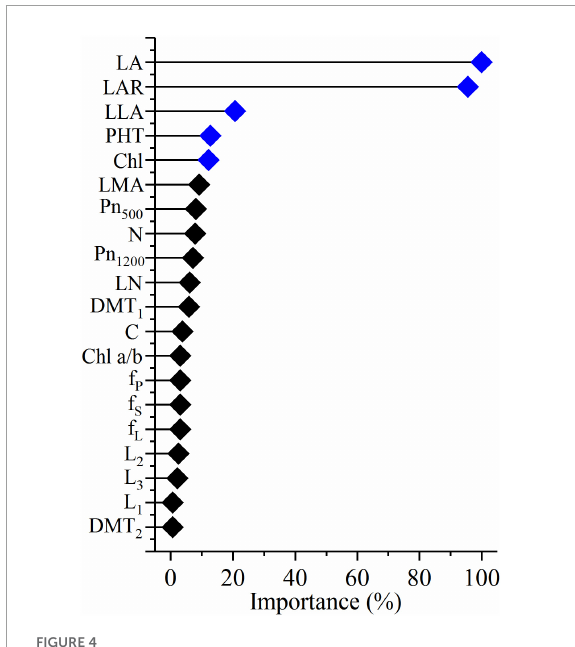
FIGURE4 Relative importance of the plasticity of morphological and physiological variables that affect the plasticity of biomass in shade. LA, leaf area per plant; LAR, leaf area ratio; LLA, leaflet area; LN, leaflet number; PHT, plant height; Chl, chlorophyll content per unit dry mass; Chl a/b, chlorophyll a/b ratio; LMA, leaf mass per unit area; Pn 500 , net photosynthetic rate per unit area at 500 µ mol m – 2 s – 1 ; Pn 1200 , net photosynthetic rate per unit area at 1,200 µ mol m – 2 s – 1 ; N, nitrogen content per unit area; LN, leaflet number; C, carbon content per unit area; DMT 1 , diameter of the first node; DMT 2 , diameter of the second node; f S , fraction of dry mass in stem; f P , fraction of dry mass in petiole; f Lr , fraction of dry mass in lamina; L 1 , first internode length; L 2 , second internode length; L 3 , third internode